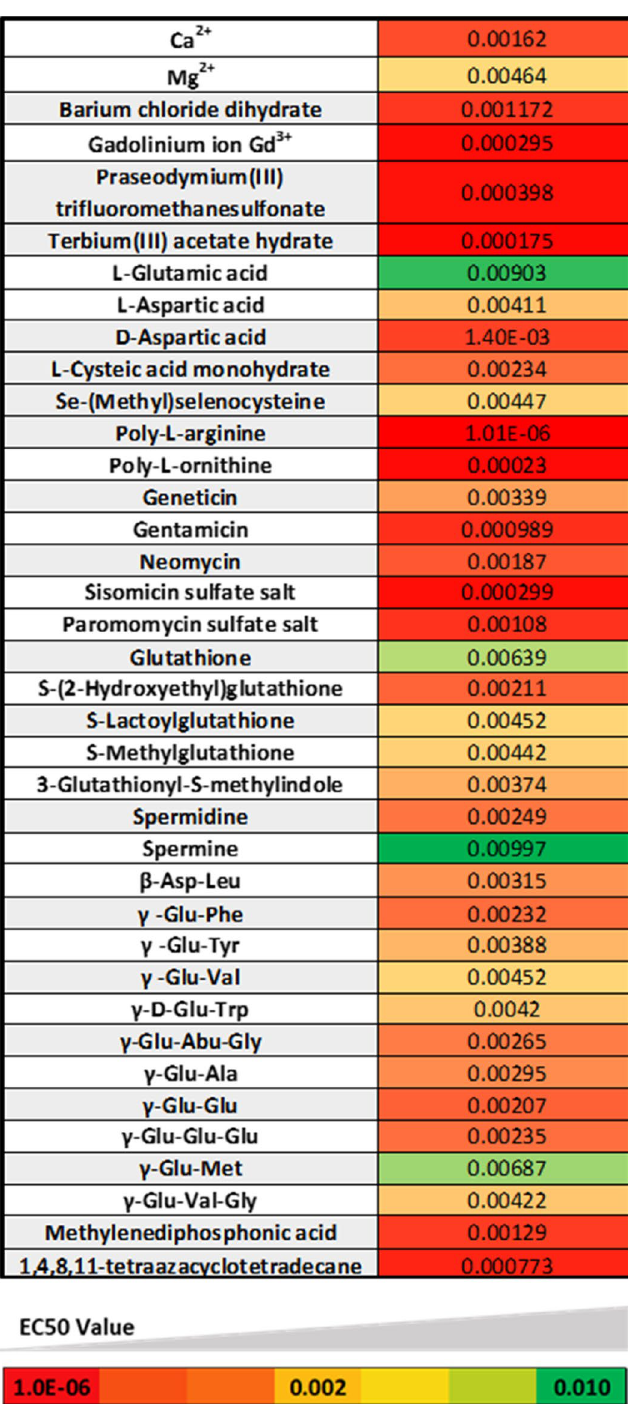
GSH, but not CaCl and MgCl exhibit kokumi effect for a human sensory panel. In order to 2 2, compare the cat in vivo response to humans, we assessed the same three compounds with a human sensory panel using assessors validated in line with ISO 8586:2012(E). Panellists were presented with each compound through